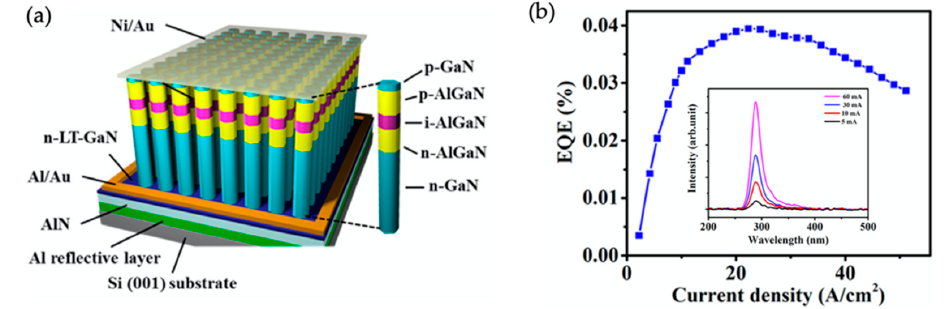
Figure 5. ( a ) Schematic of AlGaN nanowire deep UV LEDs on Al-coated Si substrate. ( b ) EQE vs. the injection current, with the inset showing the EL spectra under different injection currents (from 5 mA to 60 mA) [29].